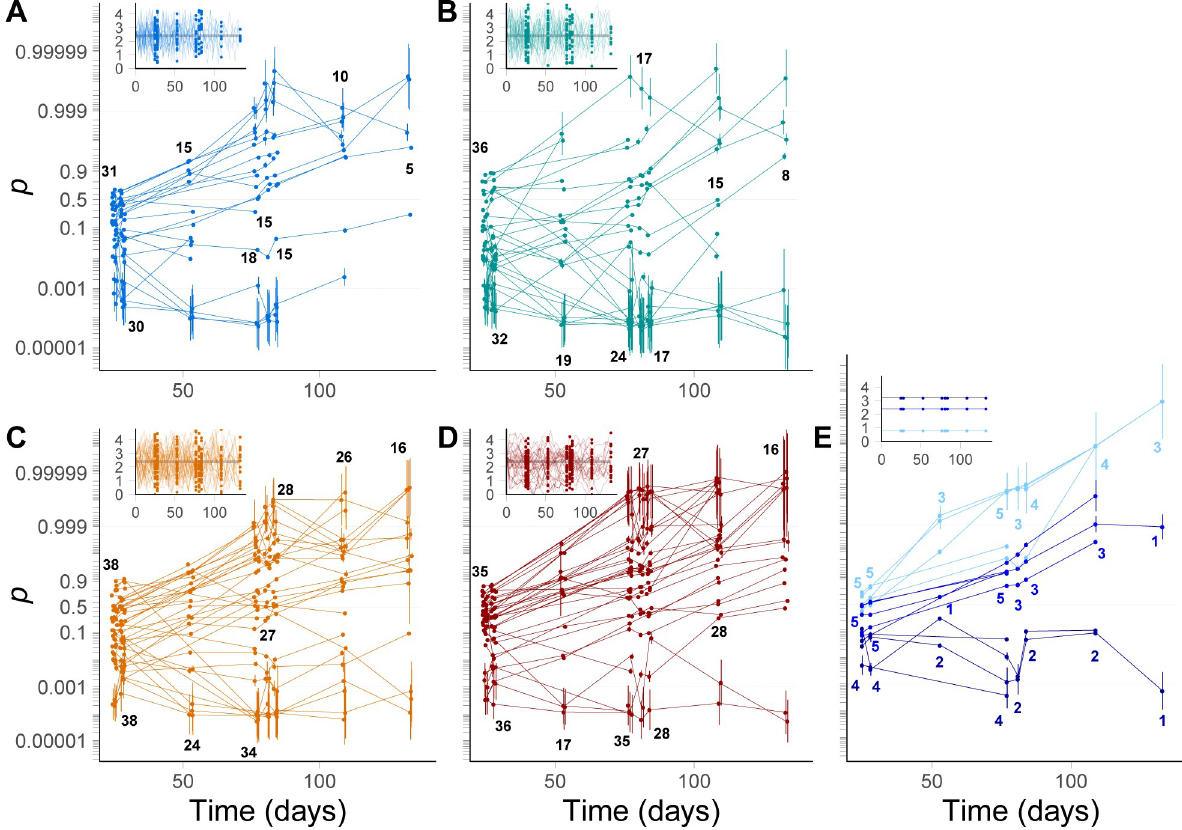
Fig 2. Frequency dynamics in fluctuating versus constant environments. Logit frequencies of all lines in fluctuating salinities (autocorrelation -0.5 (A, blue), 0 (B, green), 0.5 (C, orange), 0.9 (D, red)) and constant (E) salinities (from lighter to darker: 0.8M, 2.4M and 3.2M) are represented, with the corresponding salinity time series plotted in the insets. Frequencies were estimated as random parameters in the state-space logistic regression of choloroplastic and ITS2 marker sequences. Each line represents the frequency dynamics in one population, and numbers are the total number of populations sequenced in each salinity treatment and at each time